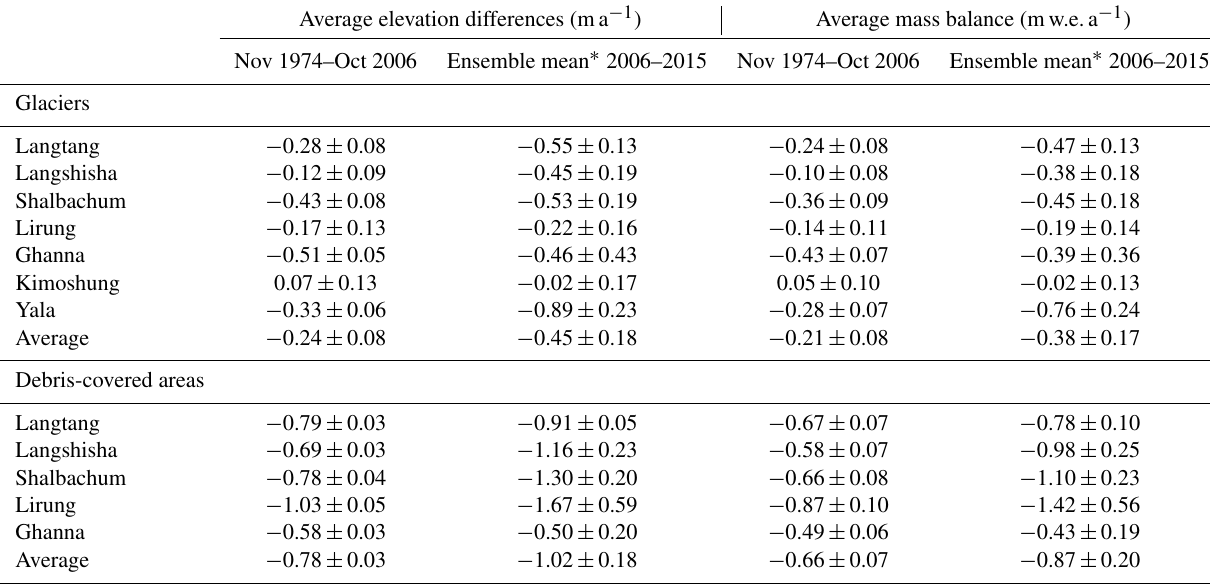
∗ Uncertainties associated with individual maps are shown in Table S1 in the Supplement. Table 4. Glacier volume and mass changes during 1974–2006 and ensemble mean during 2006–2015 ∗